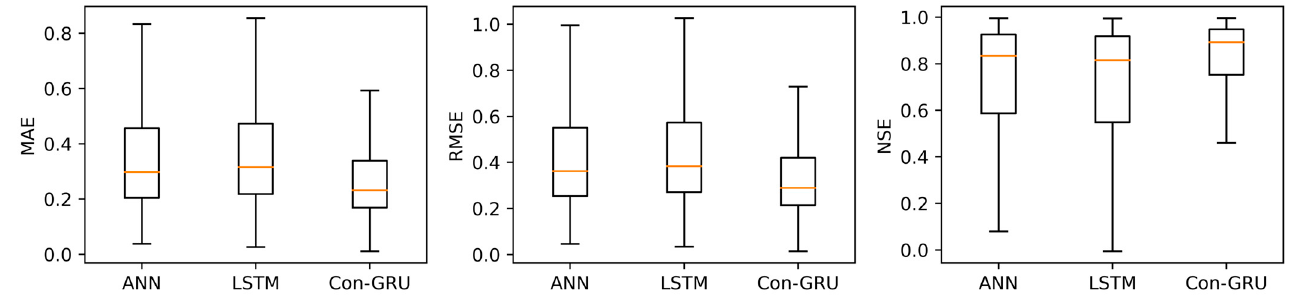
Figure 7. Comparison of three models on the validation dataset for 3 h data repair